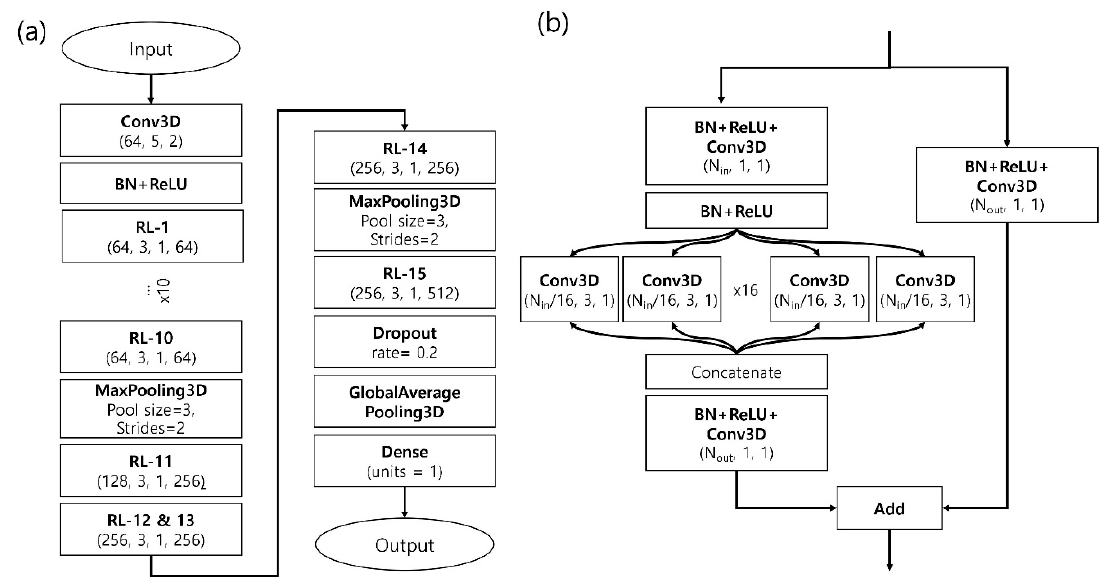
Figure 1. ( a ) The overall architecture of the network. The complete network mainly consists of 15 stacked layers of an ensemble-based residual layer (RL) block. The parentheses in the RL blocks denote (number of input channels, kernel size, stride, number of output channels). The numbers inside parentheses in the Conv3D blocks represent (number of channels, kernel size, stride). ( b ) The structure of each residual block is illustrated. A residual block consists of three stacks of convolutional layers combined with batch normalization and ReLU activation layers and a residual sum. In the middle of the block, each subset of channels is distributed to 16 separated 3-D-convolutional layers and processed in a parallel way. After being processed by the parallel convolutional layers, the output tensors are concatenated by the channel axis. Then, the agglomerated tensor is processed with a 3-D-convolutional layer with a kernel size of one to adjust the number of channels and added with a shortcut tensor, which is similar to an identical tensor of the original residual network (shown as the right path).